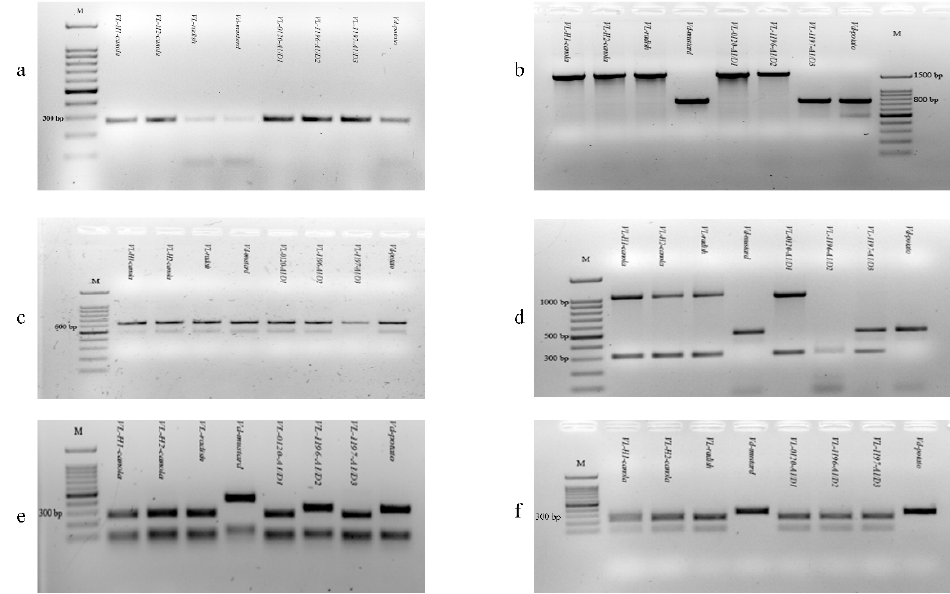
Figure 2. PCR amplification of 18S rDNA intron region ( a ); 18S rDNA ( b ); and mating type 1-1-1 ( c ) in Verticillium longisporum and Verticillium dahliae isolates. ( d ) Multiplex PCR amplification in Verticillium longisporum - Verticilliun dahliae isolates. ( e , f ) PCR-AFLP analysis of mitochondrial mtSSU-rDNA ( e